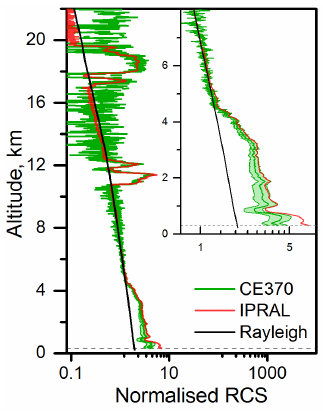
Figure 3. Comparison of the normalized range-corrected signals profiles at 532nm recorded by CIMEL CE370 lidar on-board the mobile platform (green) and IPRAL lidar (red) at Palaiseau, France, on 28 August 2017 (23:15–23:45UTC). The profiles are displayed from 300m above (complete overlap altitude of IPRAL